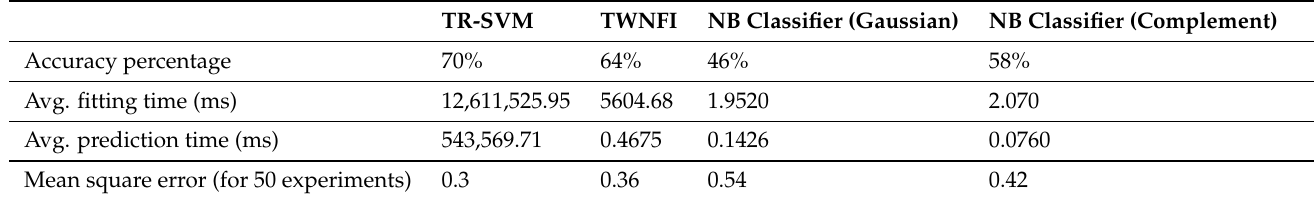
Table 3. Comparison of chosen machine learning algorithms for 1000